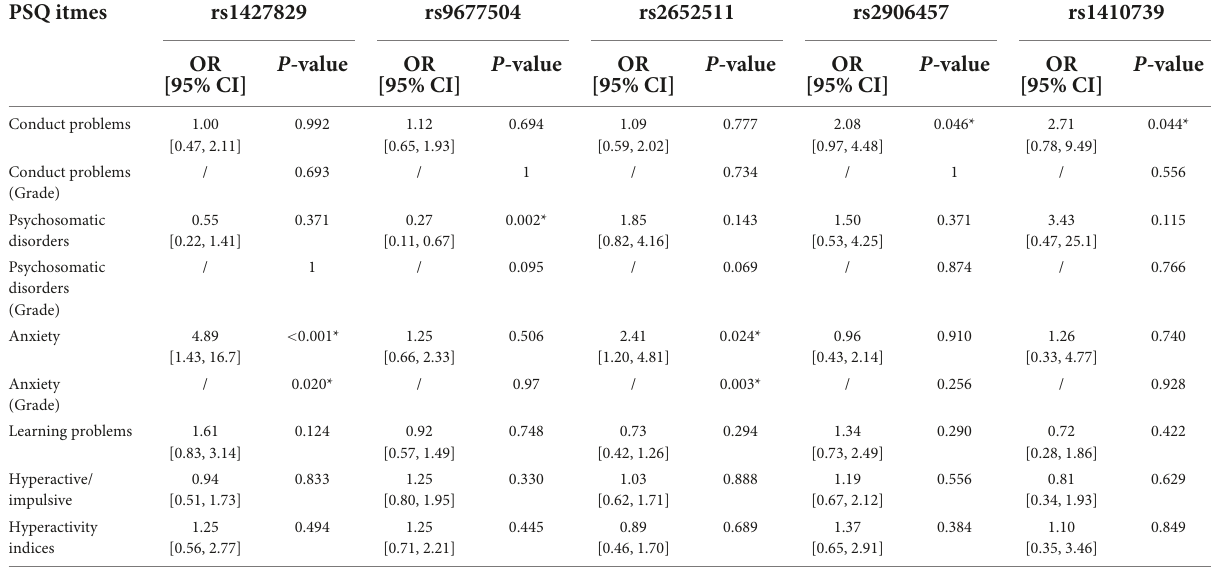
TABLE 2 Multivariate analysis results of the influence of single nucleotide polymorphisms (SNPs) on various clinical phenotypes of ADHD. PSQ